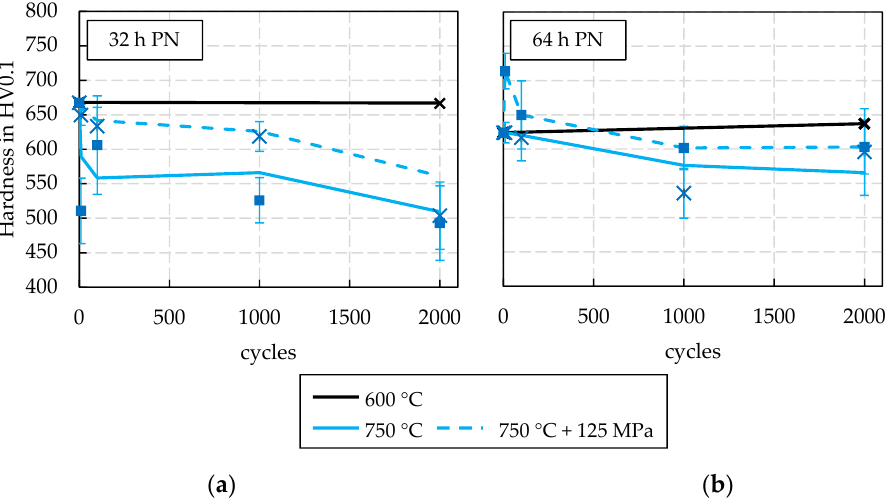
Figure 9. Results of the dynamic, cyclic tempering tests for 600 °C and 750 °C peak temperature: ( a ) 32 h PN, ( b ) 64 h PN.